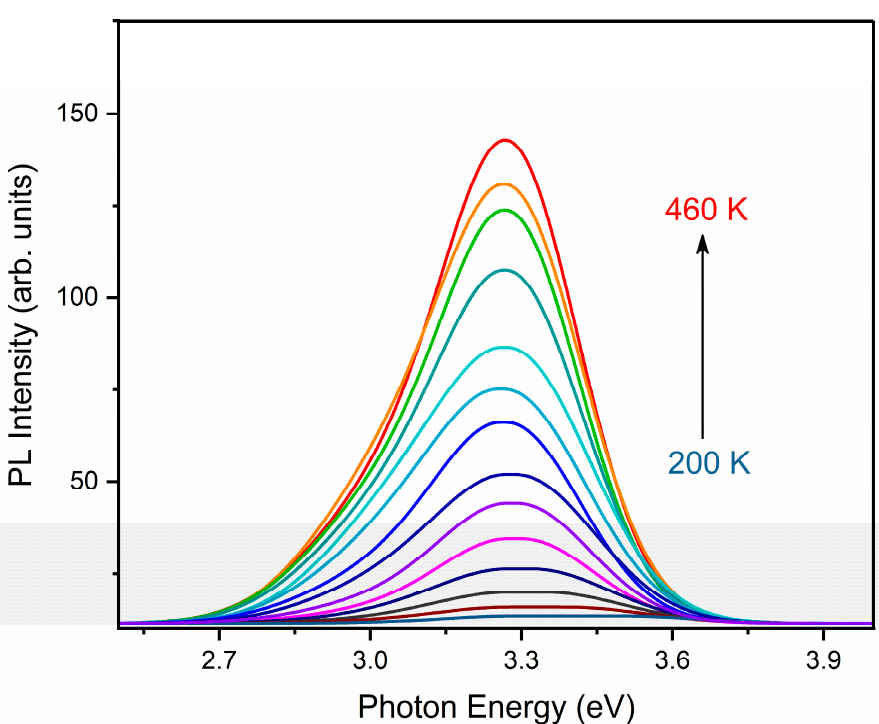
Figure 7. Temperature-dependent emission of Y 2 O 3 film excited by 5.0 eV, with a temperature range of 200 K–460 K.